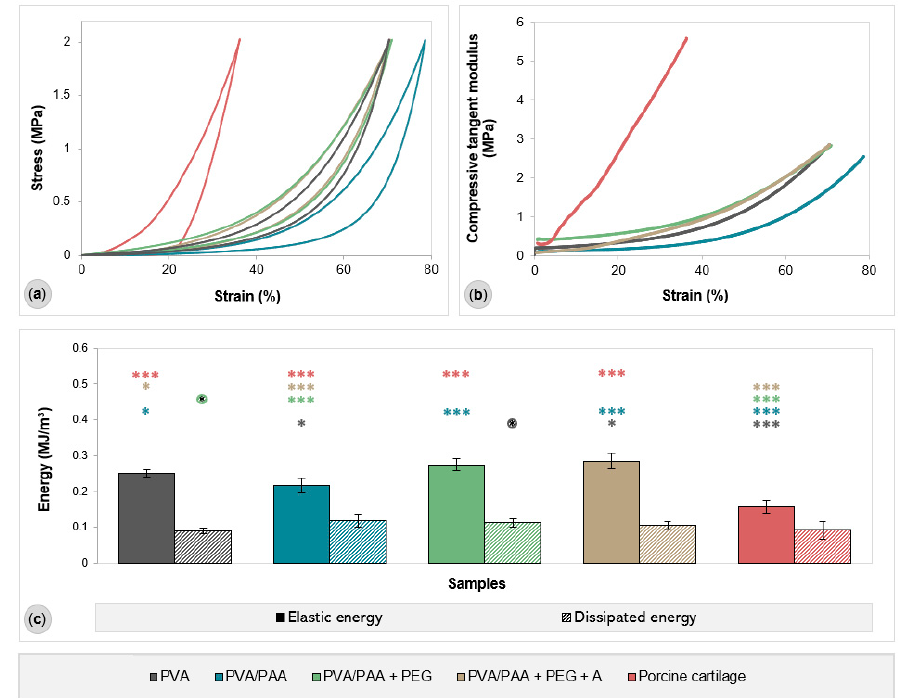
Figure 4. Typical compression stress–strain curves ( a ), compressive tangent modulus ( b ), and elastic and dissipated energies ( c ) of the samples. Error bars are the ± standard deviations, n = 5. The elastic energy data were analyzed using ANOVA ( p < 0.0001) and Tukey’s HSD test. The remaining data were evaluated using Welch’s ANOVA ( p < 0.05) and Dunnett’s T3 test. Statistical differences are indicated by asterisks (* p < 0.05, *** p < 0.0005).